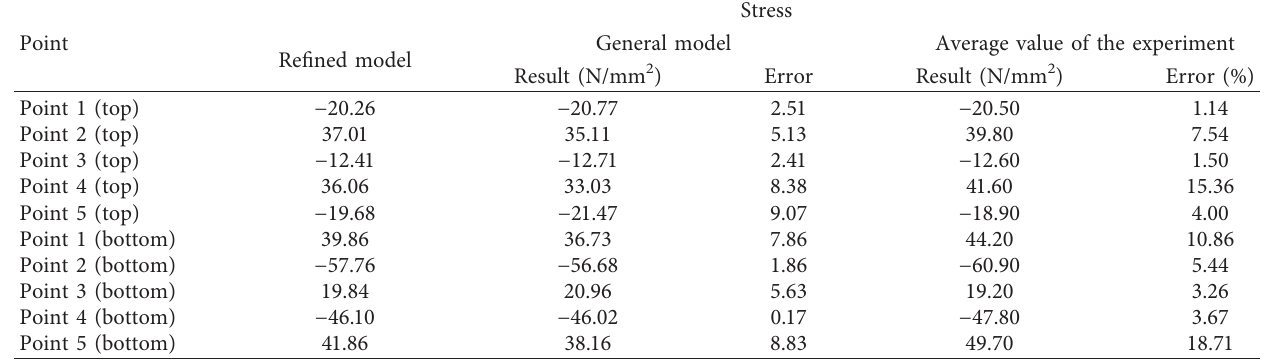
Table 6: Comparison of the stresses between the experiment and FE models.